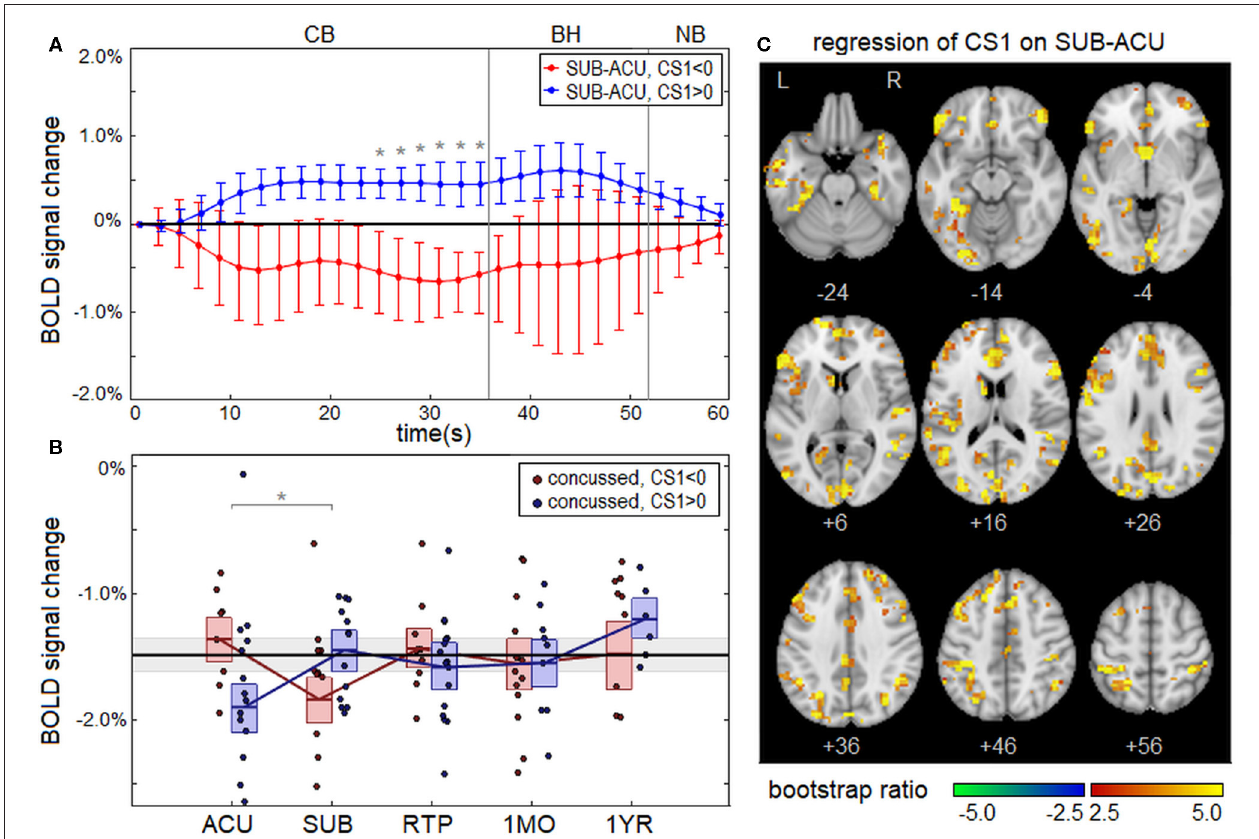
FIGURE 3 | (A) Change in the group average of the mean BOLD temporal response x t from ACU to SUB, plotted for athletes with low severity on clinical composite score 1 (CS1 < 0; red) and high severity (CS1 > 0; blue), along with the line of no effect (black). Errorbars denote 95% confidence intervals (95% CIs) of the mean and “*” denotes task time points with significant effect of CS1 on longitudinal BOLD change, at an false discovery rate (FDR) of 0.05. (B) Subject BOLD values, averaged over significant task time points (25–35s), were plotted for each imaging session. The horizontal red/blue lines denote subgroup means, and boxes indicate bootstrapped 95% CIs of the means. The mean value for controls is plotted as the thick horizontal black line, with the corresponding 95% CI shaded in gray. In the plots, “*” denotes significant longitudinal change relative to ACU. (C) Brain regions showing significant effects of CS1 on the BOLD change from ACU to